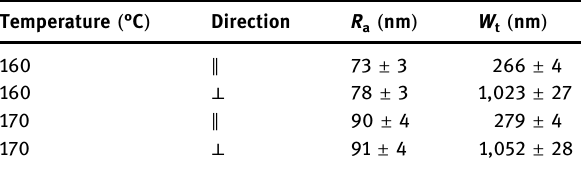
Table 1: Surface roughness parameters for the samples Temperature ( °C )